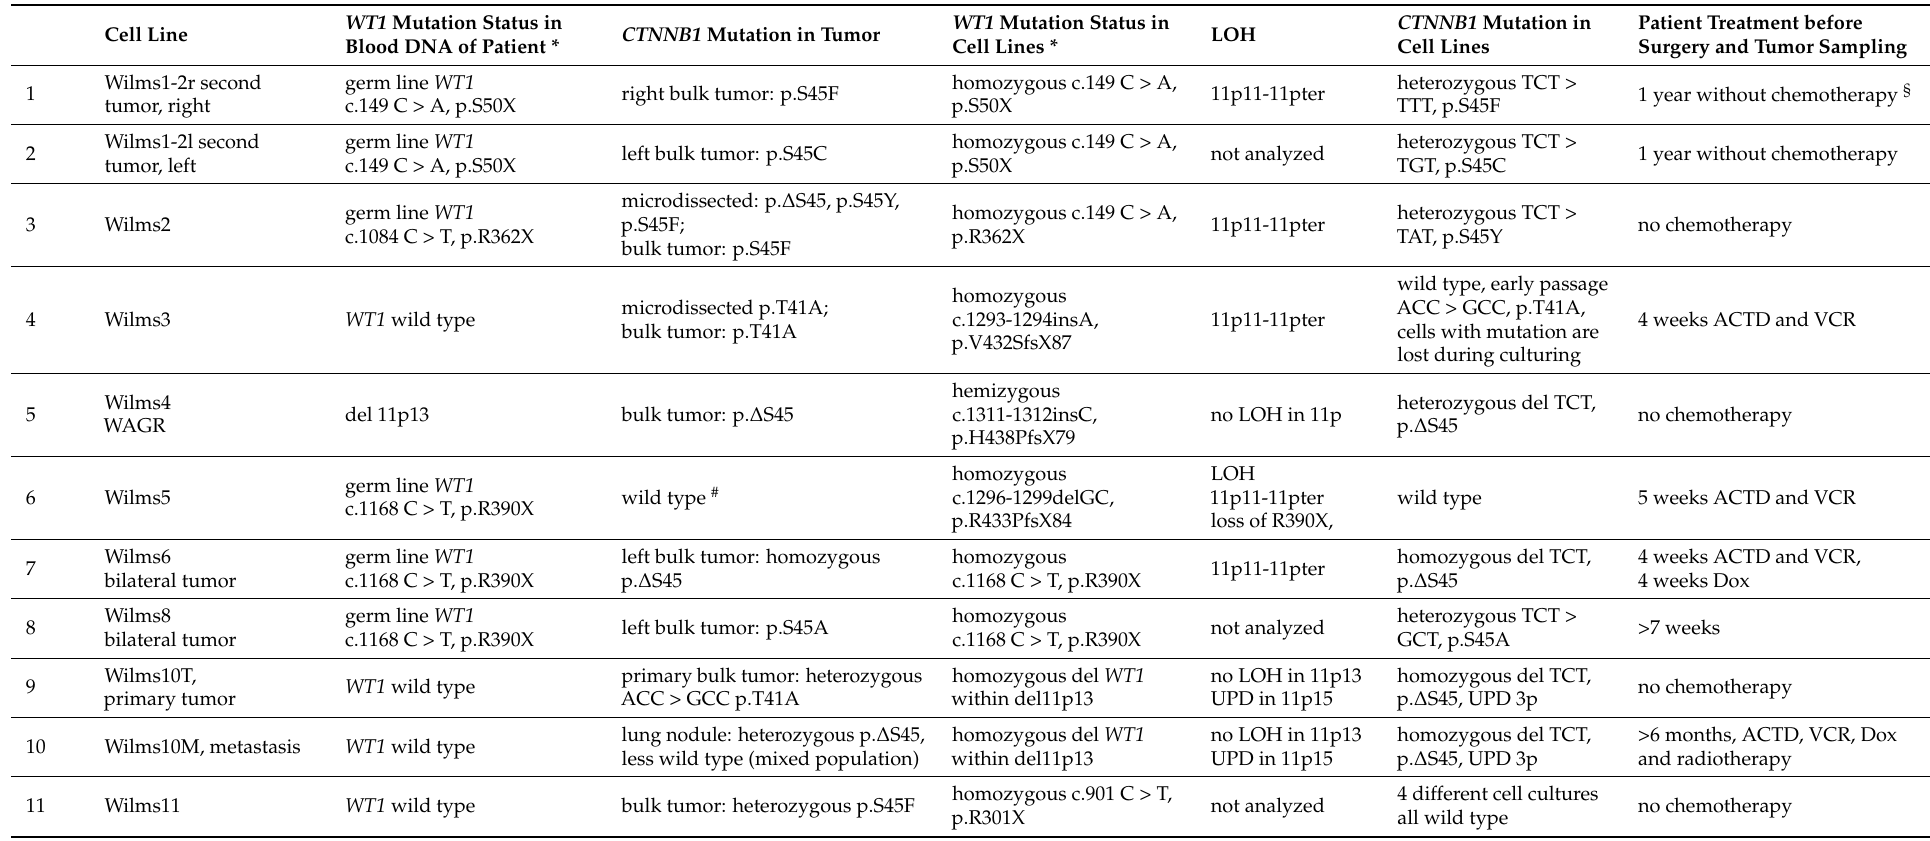
Table 1. Mutation status of WT cell lines and